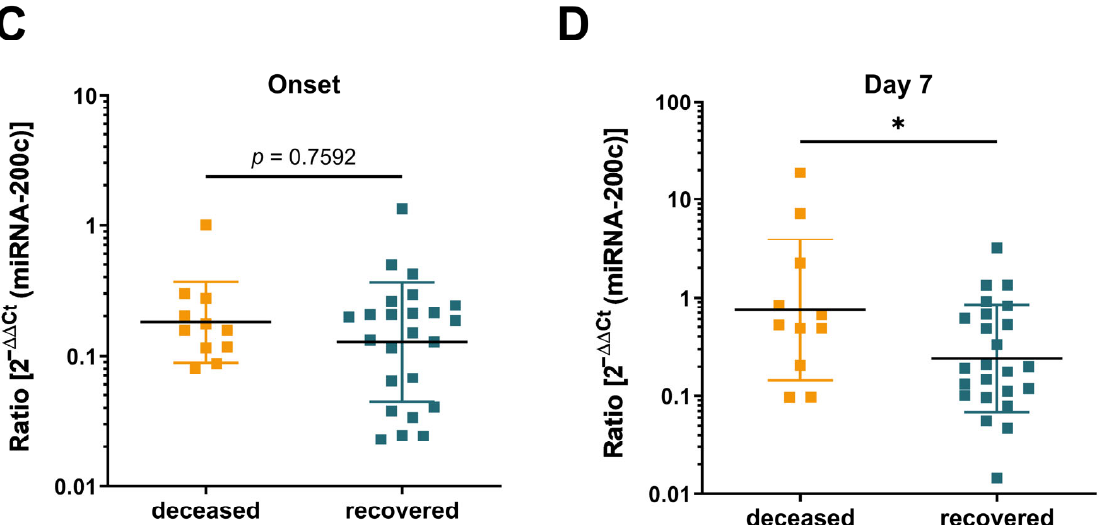
Figure 2. miRNA-200c expression levels in critically ill COVID-19 patients. ( A ) Quantitative RT-PCR analysis of miRNA-200c expression of all patients at the time of hospitalization (onset) and at day seven after hospitalization. ( B ) miRNA expression of patients with study enrollment at both time points (paired sample group; n = 35). ( C ) Expression levels of miRNA-200c at study enrollment (onset) of the paired sample group according to the clinical outcome of disease. ( D ) Expression of miRNA-200c in paired sample group at day 7 according to the clinical outcome of disease. The miRNA-200c levels were measured in triplicate. Each dot represents the median value from three measurements. The ratio represents the miRNA-200c values normalized to a healthy control group and the housekeeping gene miRNA-16. The mean values of relative quantification (ratio) of plasma miRNA-200c levels are indicated by horizontal lines. Error bars indicate the standard deviation of the mean. p -values were determined by an unpaired t -test. * p < 0.05, ** p < 0.01.